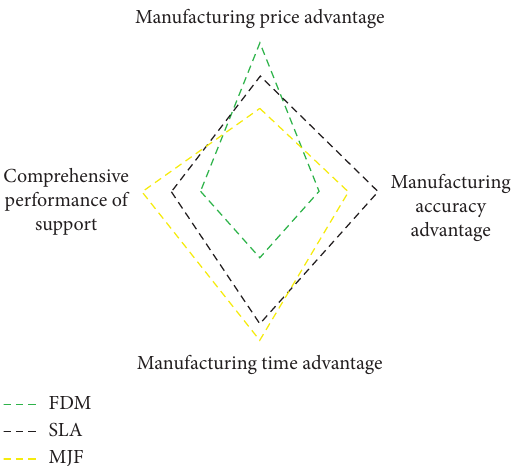
Figure 16: Comprehensive advantages of braces.